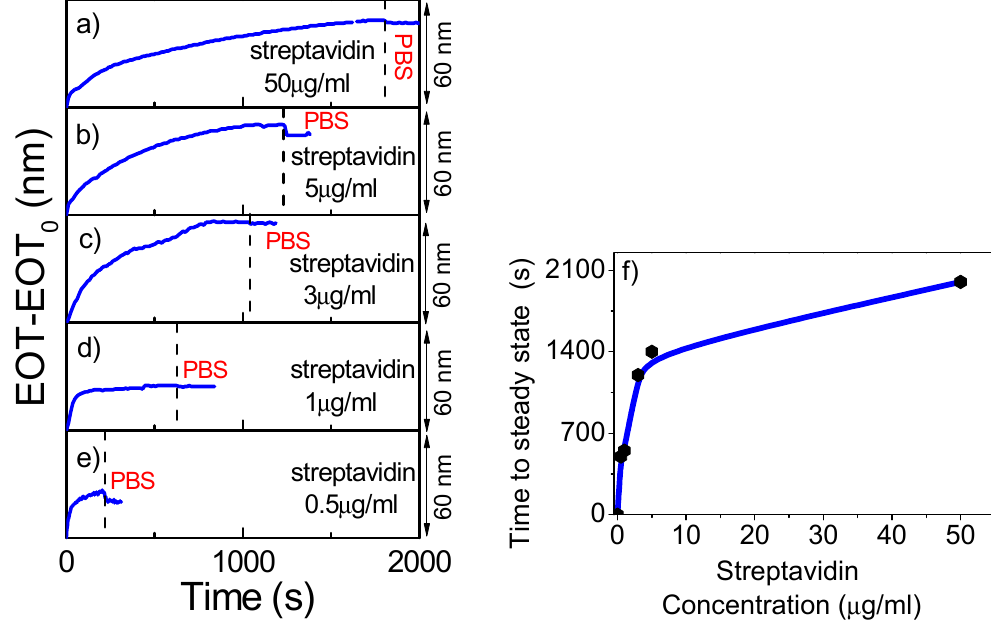
Figure 5. Variation of EOT against time for the streptavidin attachment step for different streptavidin concentrations, indicated in the plots. ( a ) 50 μ g/mL, ( b ) 5 μ g/mL, ( c ) 3 μ g/mL, ( d ) 1 μ g/mL, and ( e ) 0.5 μ g/mL. ( f ) Time to reach the steady-state against streptavidin concentration.